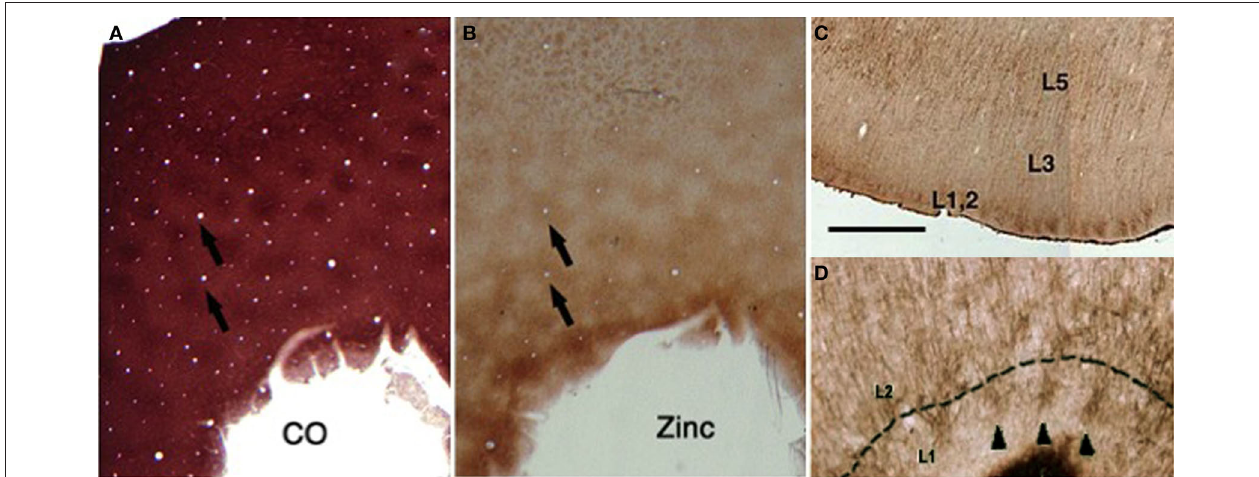
section through the posterior orbitofrontal cortex of macaque, where MAP2 immunohistochemistry reveals distinct clusters of apical dendrites at the border of layers 1 and 2. These are likely to co-localize with zinc-positive terminations. (D) Higher magnification of C, where three dendritic clusters are indicated by arrowheads. (C) and (D) are modified from Figure 3 of Ichinohe and Rockland (2004). Scale bar in (C) = 1.0 mm, 160 μm for (D) , and 600μm for (A) and (B)